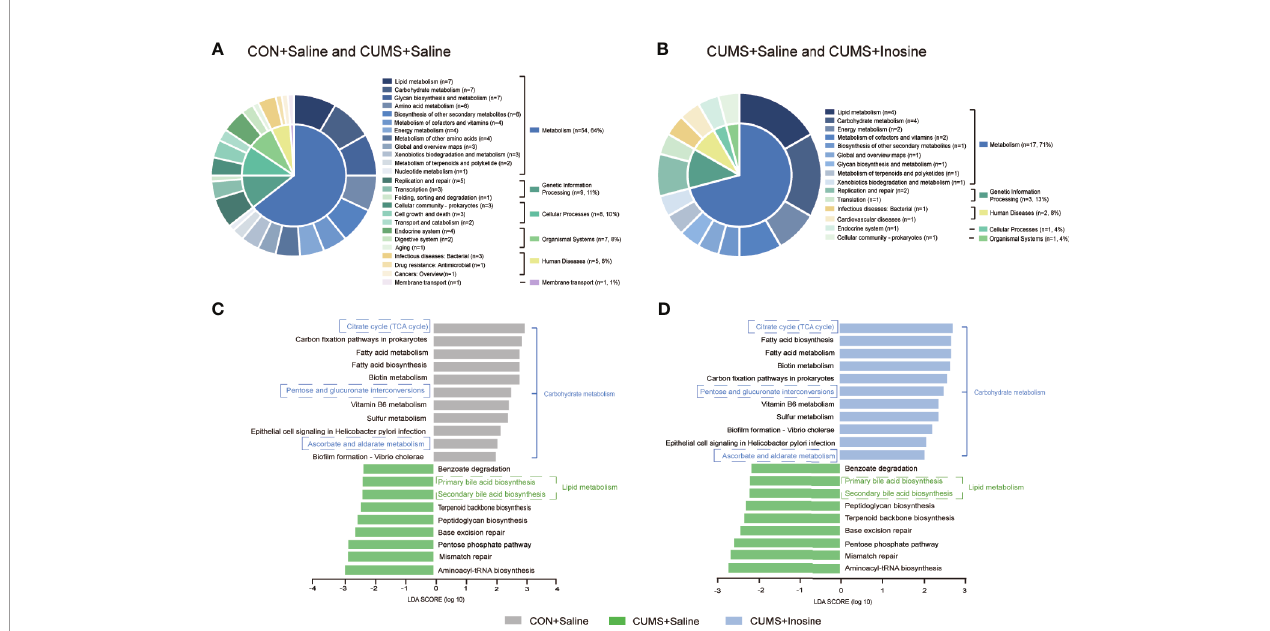
FIGURE 5 | The related functional enrichment in the KEGG pathway. (A) The pie chart of discriminative KEGG pathways between the CON+saline and CUMS+saline groups. (B) The pie chart of discriminative KEGG pathways between the CUMS+saline and CUMS+inosine groups. (C) The mutual discriminative KEGG pathways among three groups representing in CON+saline and CUMS+saline groups. (D) The mutual discriminative KEGG pathways among three groups representing in CUMS+saline and CUMS+inosine groups. The discriminative KEGG pathways among three groups were identi fi ed by linear discriminant analysis effect size, only when LDA > 2.0 and p -value < 0.05 were considered signi fi